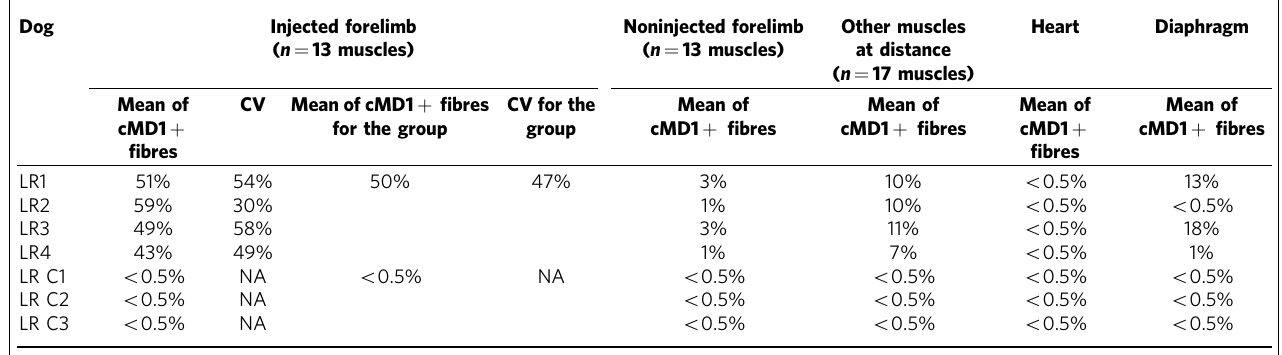
Table 2 | Levels of cMD1-positives fibres found after immunostaining analysis (NCL-DYSB) within the muscles of GRMD dogs injected by the LR